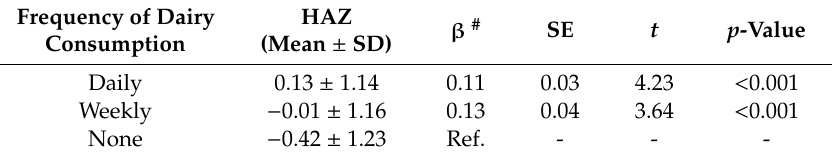
Table 3. Association between the HAZ and the frequency of dairy consumption.